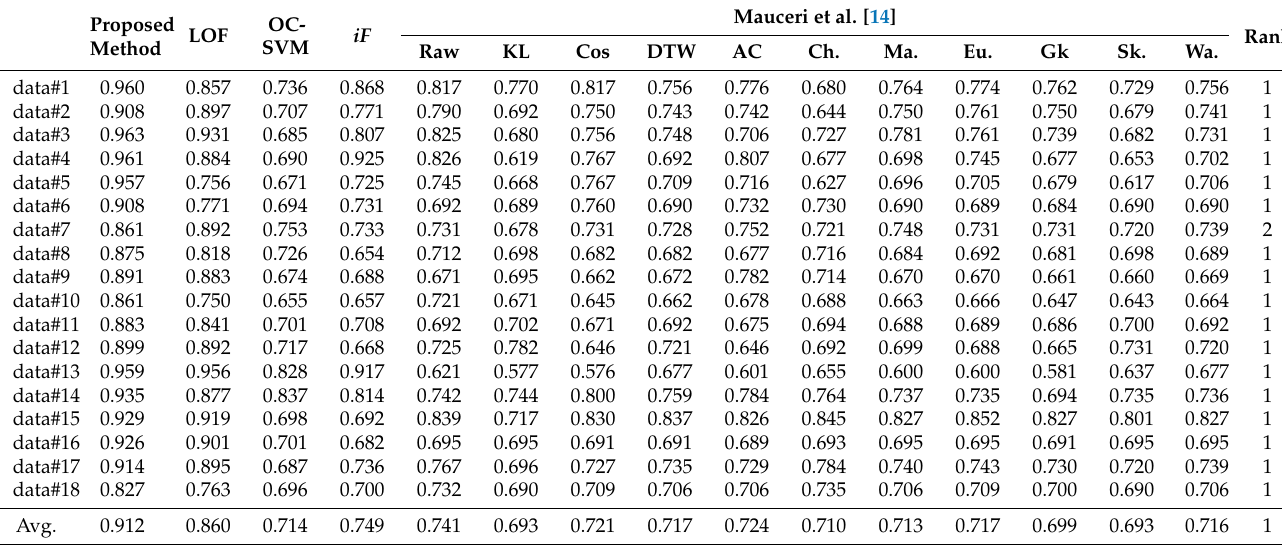
Table 1. Experimental results in terms of accuracy.